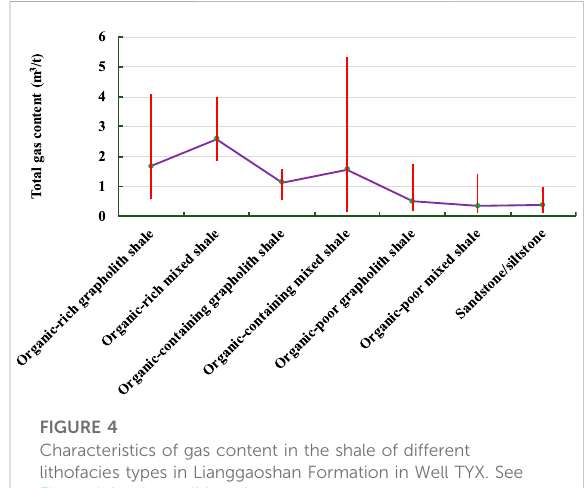
FIGURE 4 Characteristics of gas content in the shale of different